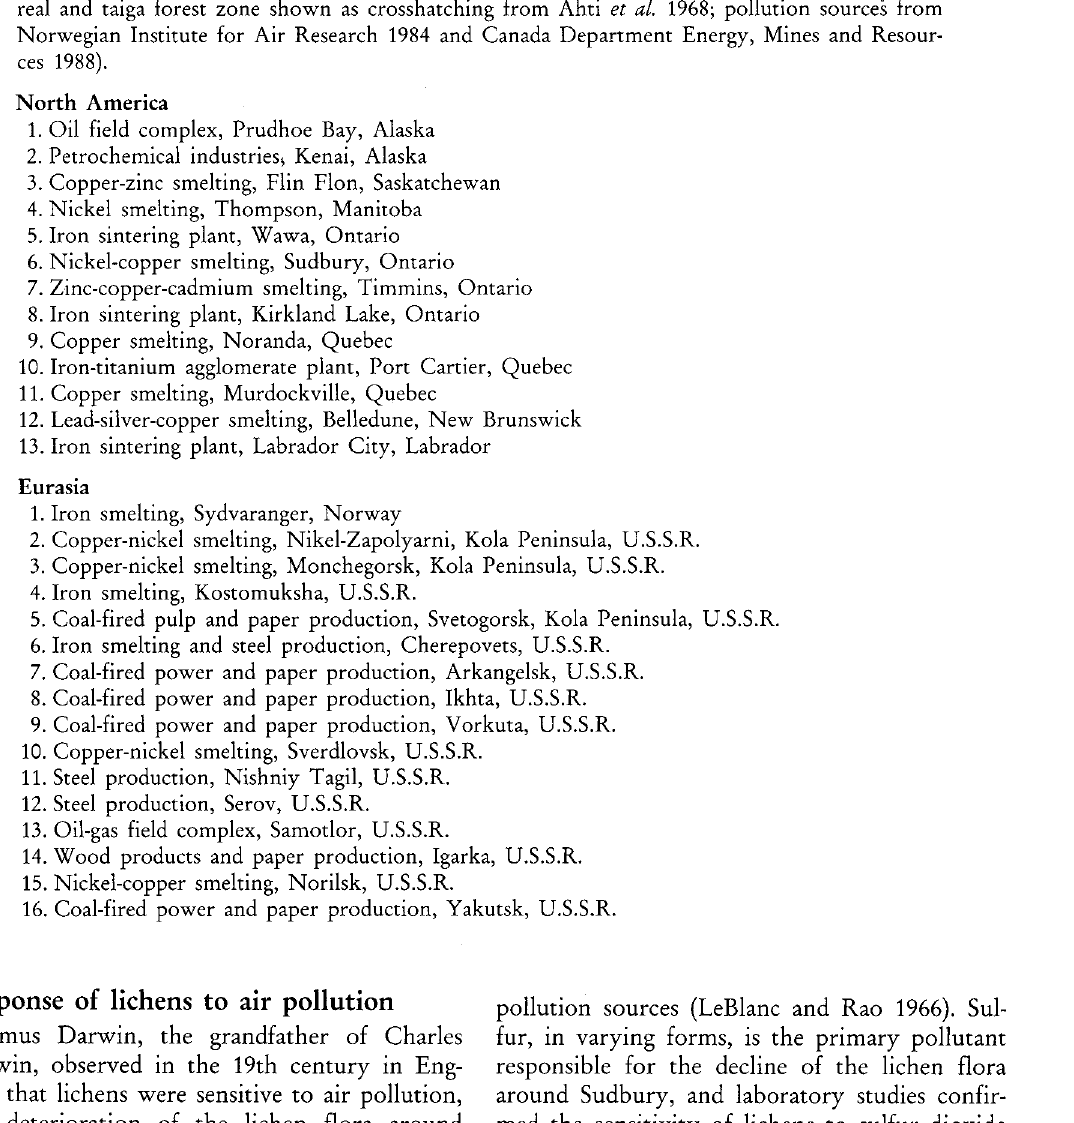
Fig. 1. Major point sources of atmospheric pollution in and adjacent to the boreal and taiga forests (Bo real and taiga forest zone shown as crosshatching from Ahti et al. 1968; pollution sources from Norwegian Institute for Air Research 1984 and Canada Department Energy, Mines and Resour ces